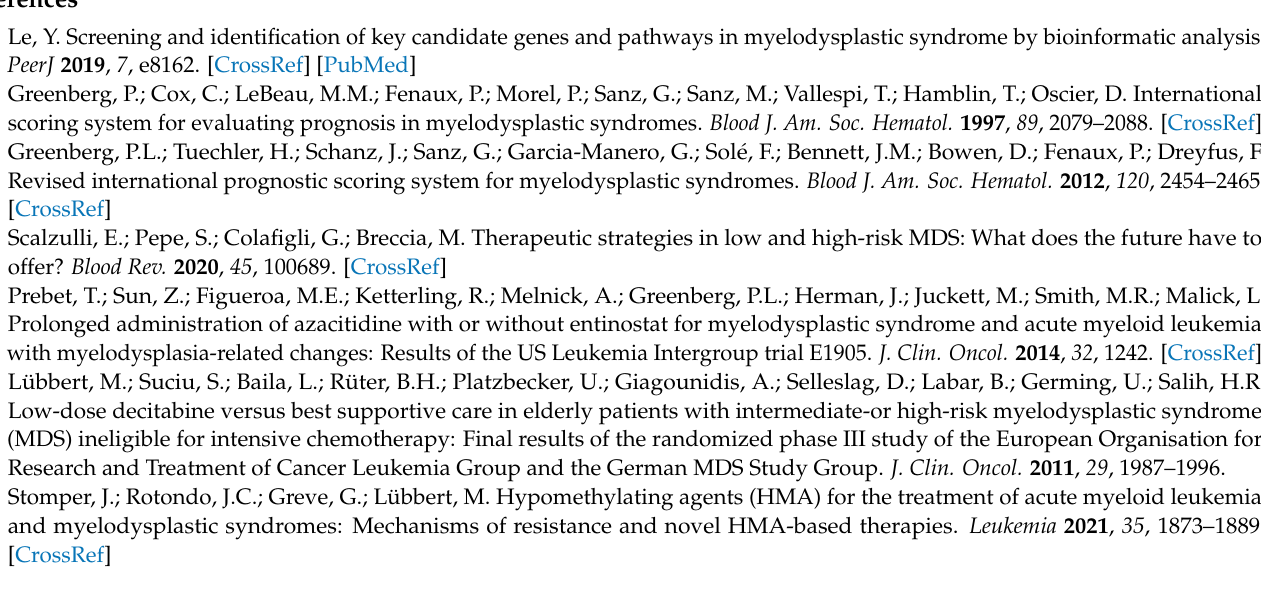
DEGs. Table S2: A cluster heatmap showing 189 differentially expressed genes. Table S3: The 30 most differentially expressed genes from the volcano plot. Table S4: DEGs between F-36P and F-36P/DEC cells. Table S5: Functional roles of module genes. Table S6: Expression levels of 38 genes in bone marrow from MDS